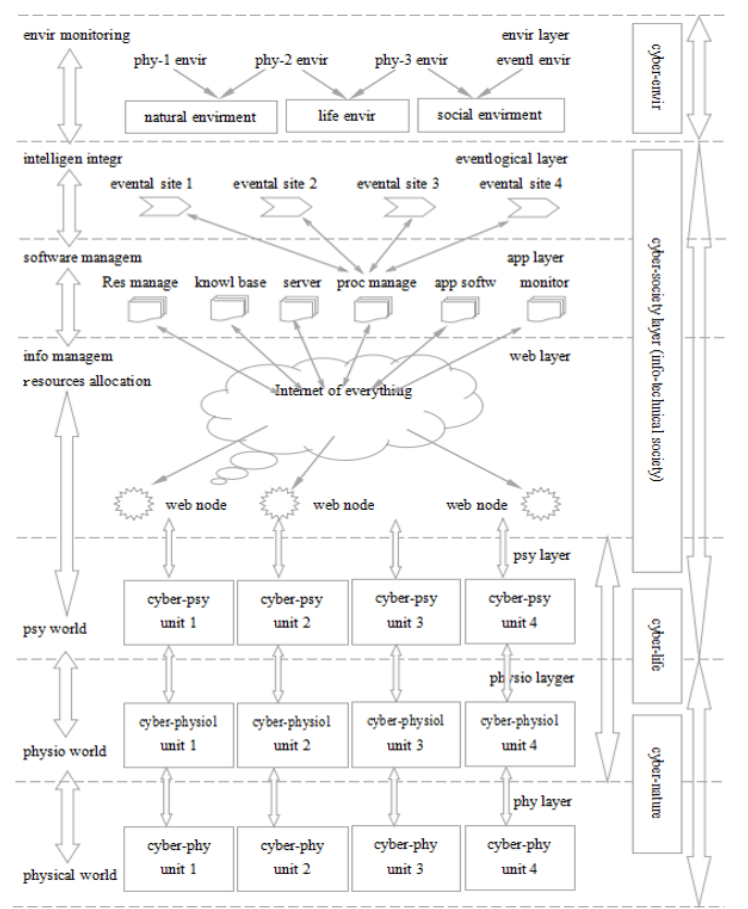
Fig. 4. Super metauniverse Systems (SMS) based on sky-earth computing